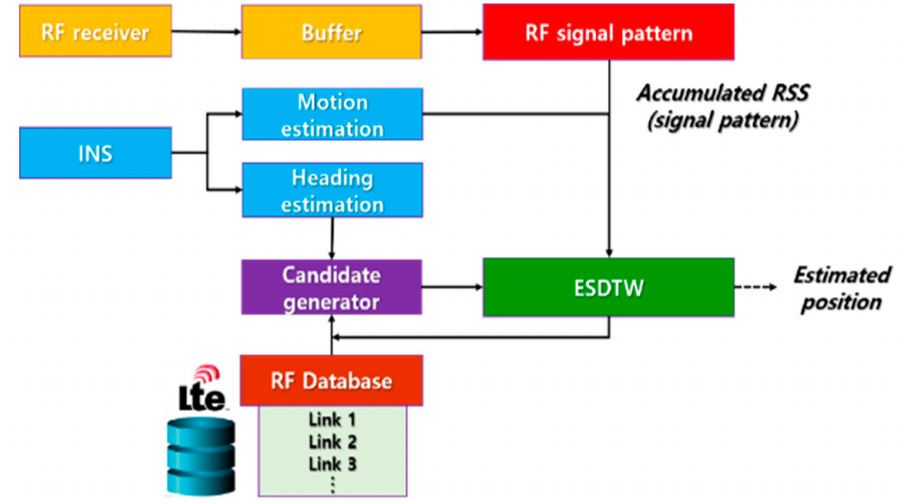
Figure 1. Block diagram of proposed system.